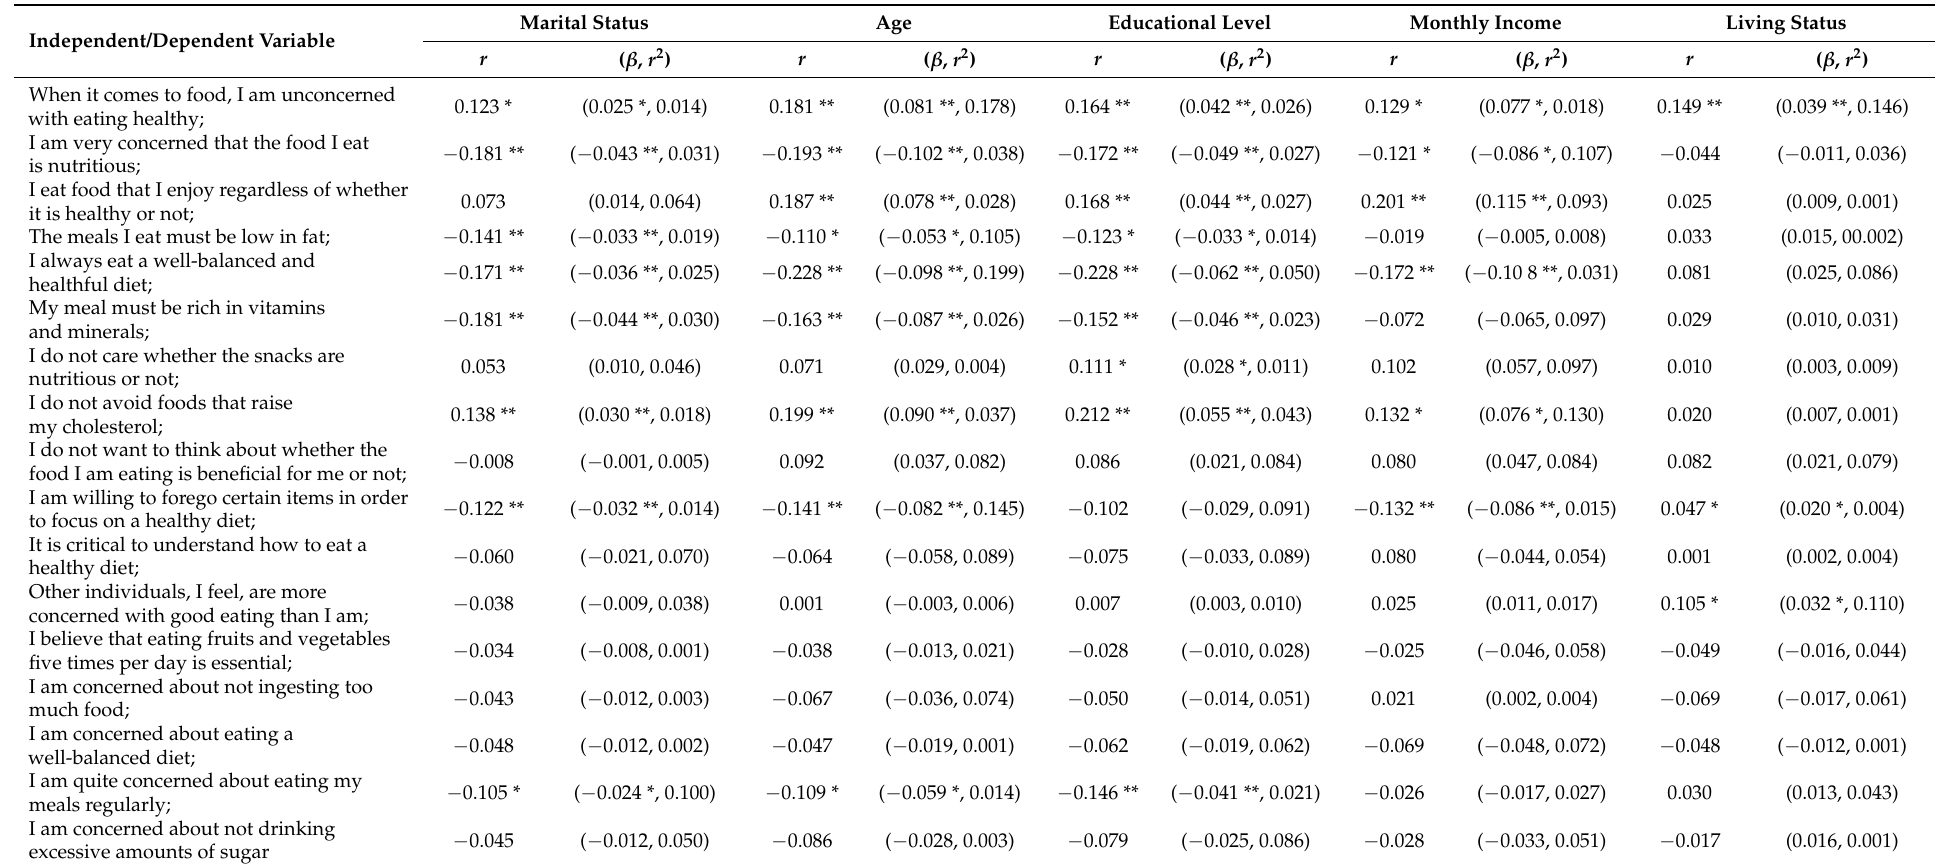
Table 6. Spearman correlation coefficients ( r ) and simple linear regression analysis ( β , r 2 ) between demographic characteristics and food policy awareness after calorie labeling for males ( n =